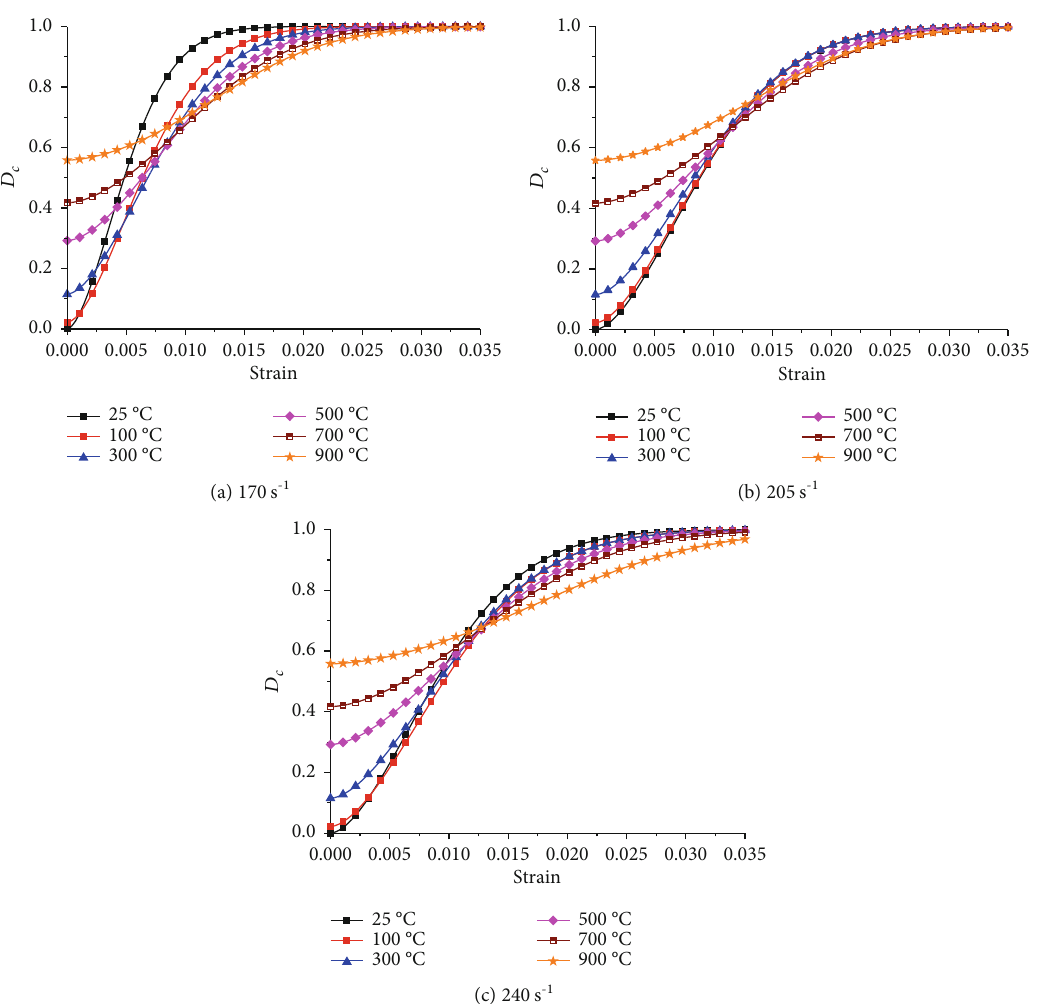
Figure 6: Dynamic damage growth curves of deep sandstone specimen with various temperatures.